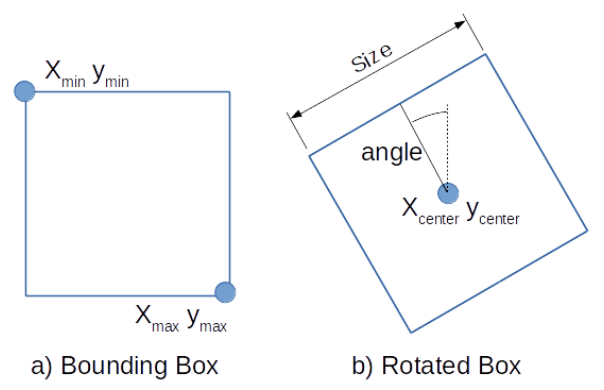
Figure 4. ( a ) Definition of Bounding Box (BBox); ( b ) Definition of Rotated Box (RBox).